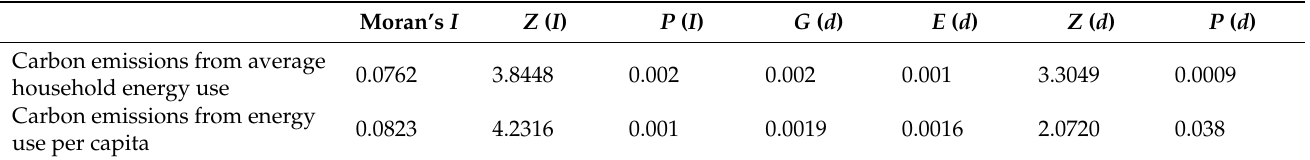
Table 5. Estimation of Moran’s I and general G for household energy consumption in